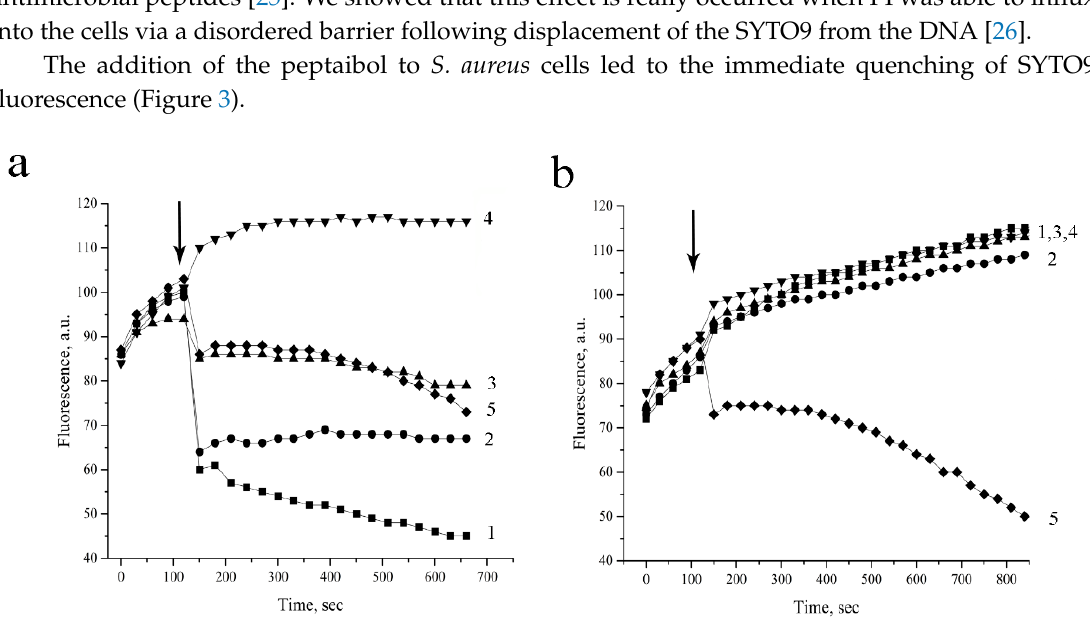
Figure 3. Dynamic of permeation of SYTO 9 into S. aureus 209 P ( a ) and E. coli MG 1655 ( b ) cells treated with emericellipsin A. Designations: 1—75 µg/mL; 2—32.3 µg/mL; 3—16 µg/mL; 4—negative control; 5—positive control. If bacterial membranes are permeabilized, PI penetrates into the cell. What follows is SYTO 9 getting displaced from DNA, which leads to a decrease in luminescence intensity in a green region of the spectrum. Pure-water and 20% alcohol served as negative and positive controls, respectively. Arrows show the time of test-substance.